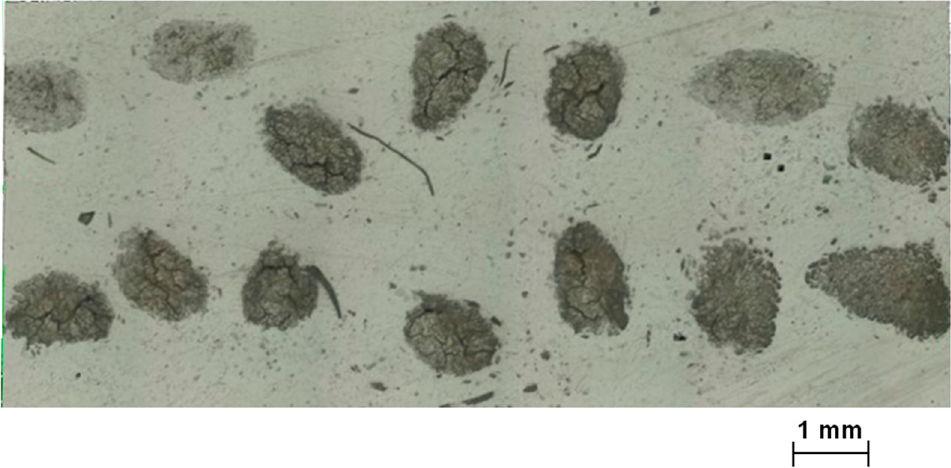
Figure 3. Optical micrograph of cross section of epoxy–kenaf composite for measurement of fibers’ volume fraction with magnification of 5 × .